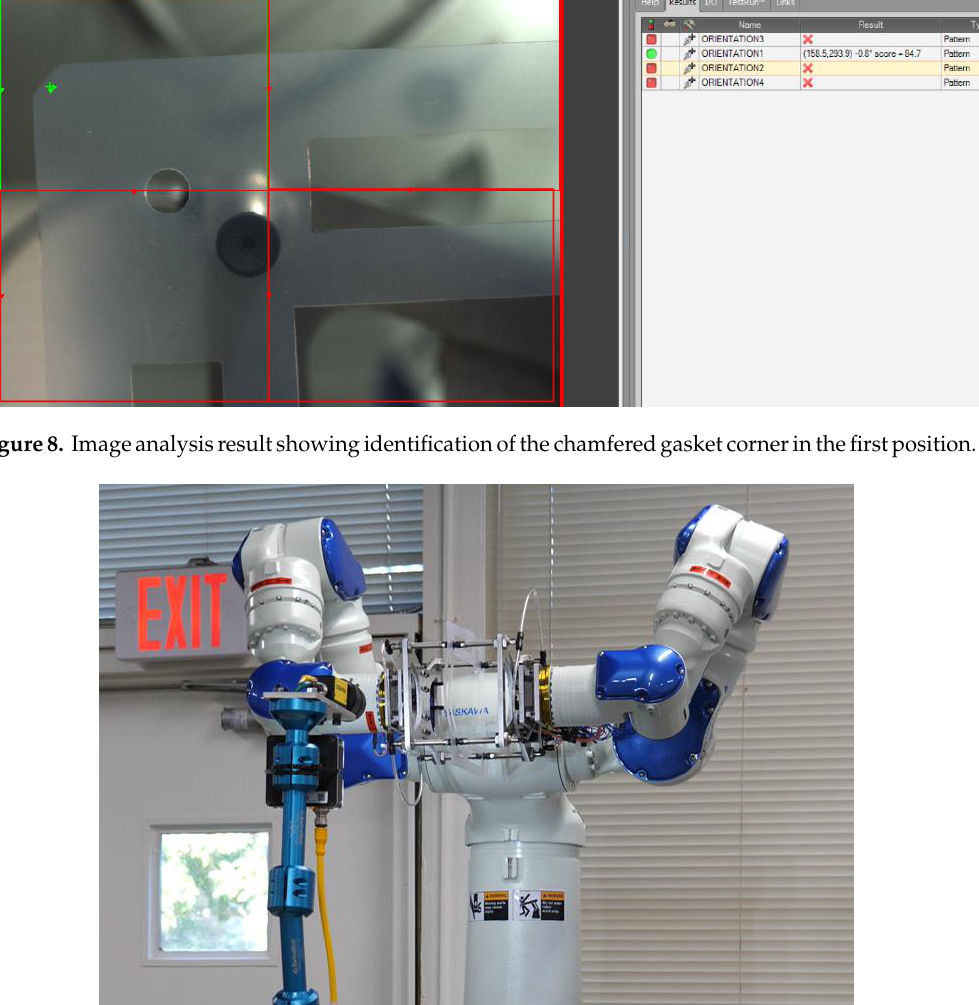
Figure 7. Machine vision process cases and the actions taken for each image analysis result. The insert shows the orientation of axes one and two relative to the insertion direction of the fuel cell component in the presenter and in fuel cell stack. Flipping the fuel cell component was achieved by passing it from one robot hand to the other. This process was equivalent to rotating the component 180° about axis one.